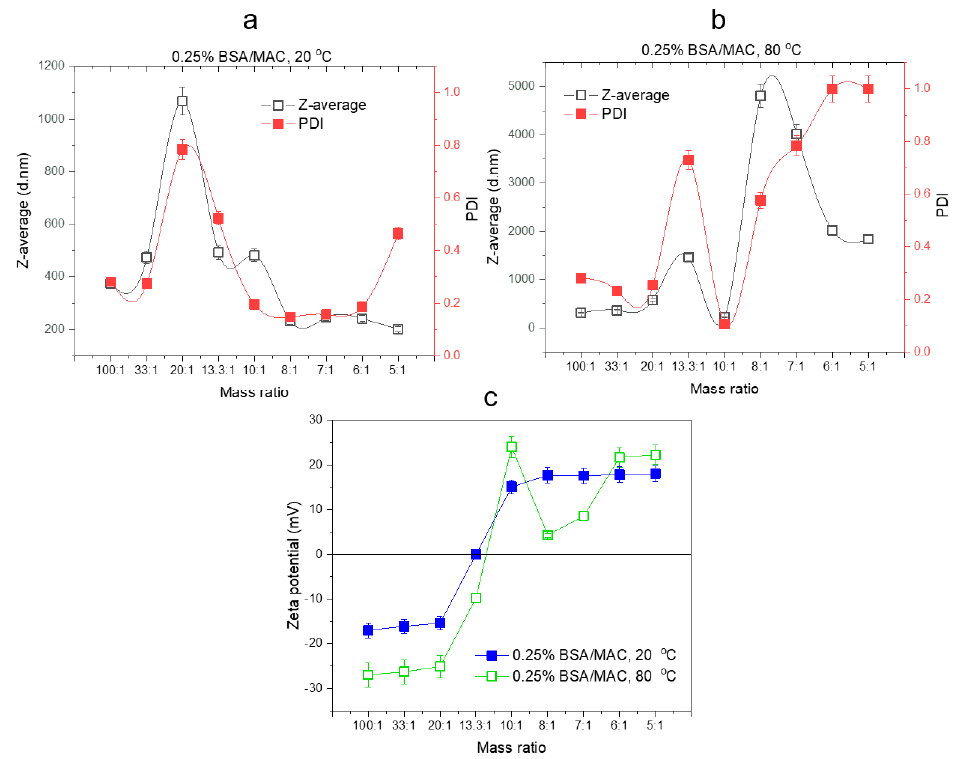
Figure 4. DLS ( a , b ) and zeta potential ( c ) results of nanogels synthesized with different weight ratios BSA / MAC (0.25% w / v ). Polymers 2020 , 12 , x of BSA/MAC (0.25% w/v).